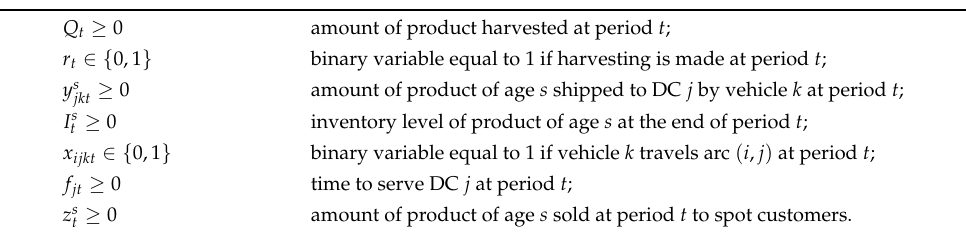
Table 2. Notation: decision